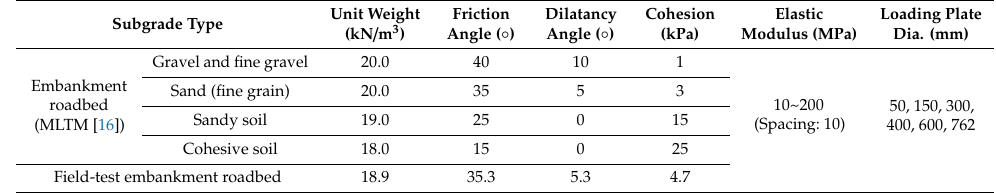
Table 2. Values of the parameters used in the numerical analysis.